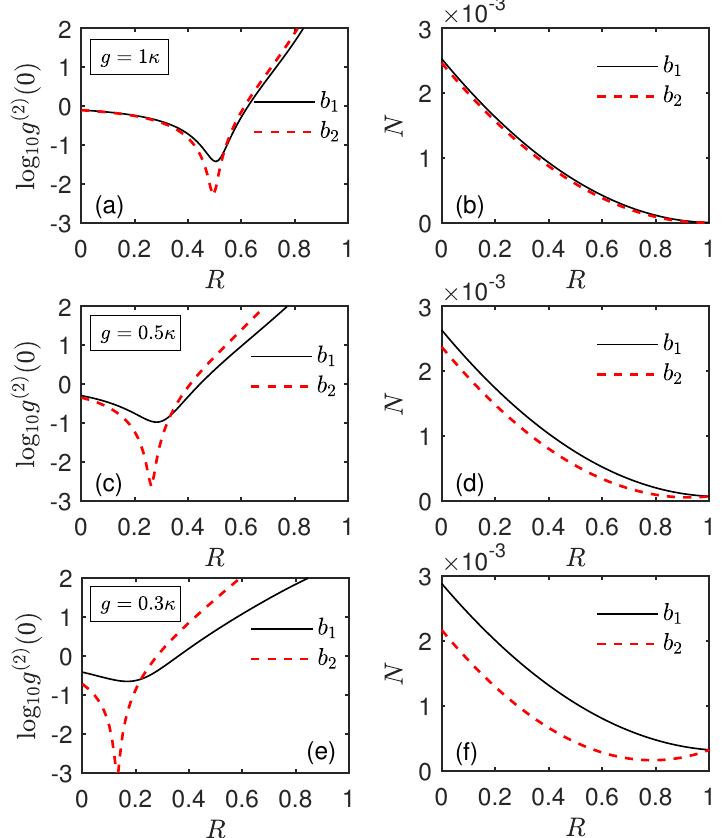
Figure 7. ( a , c , e ) Steady-state equal-time second-order correlation function g ( 2 ) ( 0 ) , and ( b , d , f ) the phonon number N of the two SAW modes b 1 and b 2 versus the ratio R of two driving strengths in the mechanical resonant case ∆ = 0. Here, the black solid line and the red dashed line correspond to the cases of modes b 1 and b 2 , respectively. The system parameters are the same as in Figure 2 except for ( a , b ) g = κ , ( c , d ) g = 0.5 κ , and ( e , f ) g = 0.3 κ